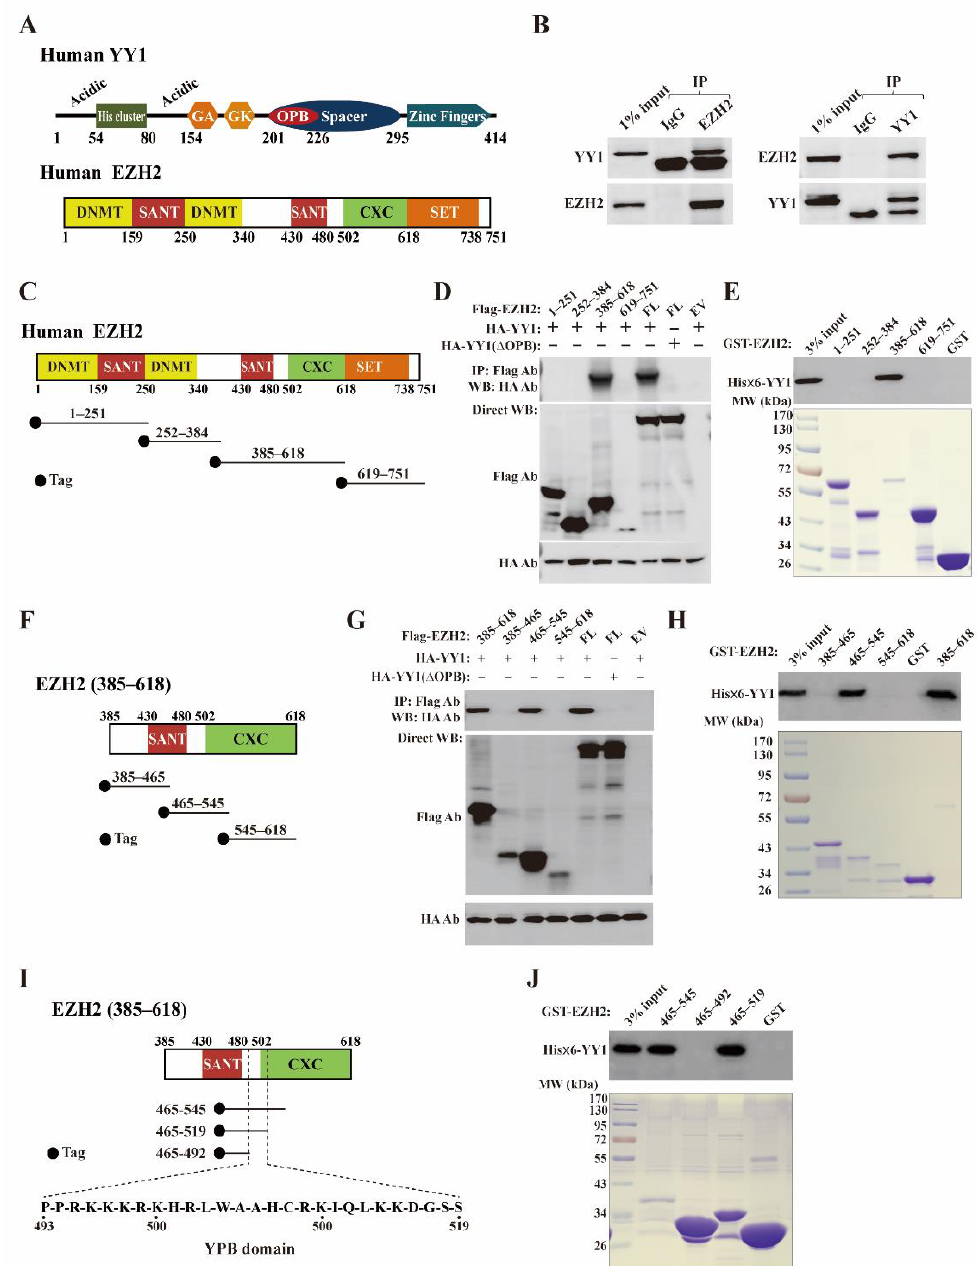
Figure 1. Identification of YY1 binding site on EZH2 protein. ( A ) Schematic diagrams of the domain structures of YY1 and EZH2 proteins based on previous reports [30,39]. In the domain structure of YY1, “Acidic” represents a region containing enriched aspartic and glutamic acids, “His cluster” contains 11 consecutive histidines, “GA” and “GK” depict regions enriched by glycine/alanine and glycine/lysine, respectively; OPB: oncoprotein binding; the Spacer region and Zinc finger domain are also denoted. In the domain structure of EZH2, “DNMT” is the binding domain of DNA methyltransferase 1 (DNMT1), “SANT” denotes the SANT domain regulating chromatin accessibility [40],“CXC” is the cysteine-rich domain, and the SET domain is also denoted. ( B ) Western blot analyses of endogenous YY1 and EZH2 interaction by co-immunoprecipitation (co-IP). MDA-MB-231 cell lysates (800 µg) were incubated with 2 µg of EZH2 antibody (cat# 5246S, left) or YY1 antibody (cat# sc-281, right), followed by the incubation of Protein A/G beads and extensive washing. The samples were analyzed by Western blot using EZH2 and YY1 antibodies as indicated. ( C , F,I ) Diagram of EZH2 mutants generated to map its YY1 binding region. The tag is either an HA epitope or GST. ( D , E , G – I ) Co-IP ( D , G ) and GST-pull down ( E , H , J ) studies to determine the YY1 binding region on the EZH2 protein. FL: full length; EV: empty vector; IP: immunoprecipitation; Direct WB: Western blot analysis of samples without IP; YPB: YY1 protein binding.